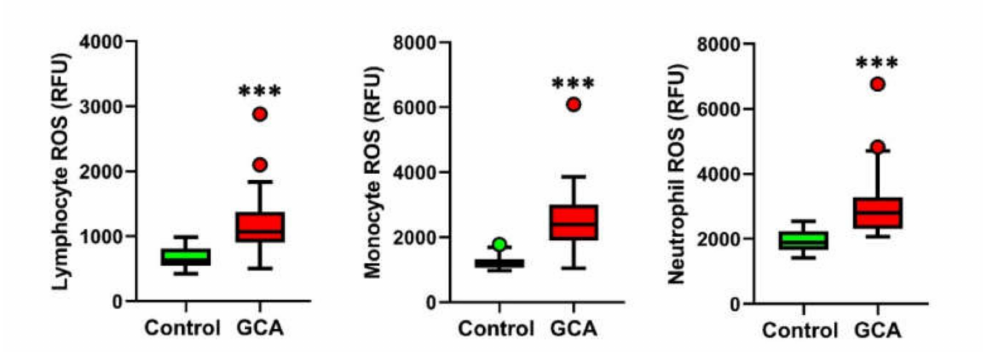
Figure 1. Blood leukocyte ROS production in the GCA patients and controls. Lymphocyte, monocyte and neutrophil ROS production in the GCA patients ( n = 30) and controls ( n = 30). *** p < 0.001.